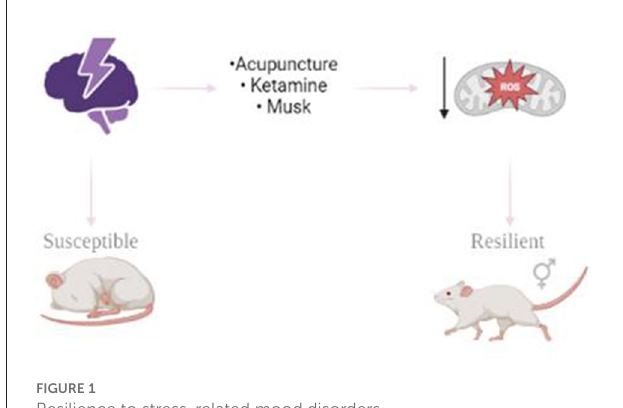
FIGURE1 Resilience to stress-related mood